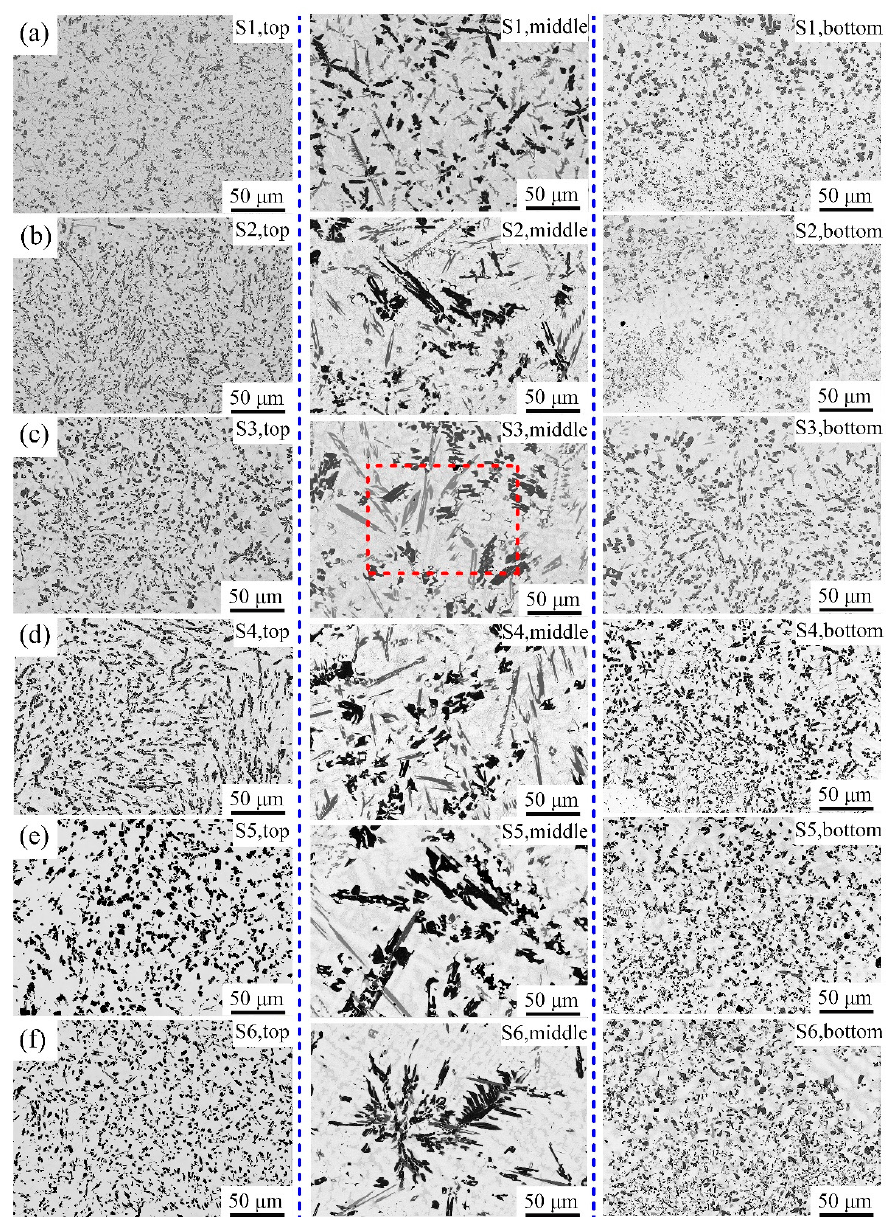
Figure 5. SEM images of the microstructure of the coatings from S1 to S6: ( a ) S1, ( b ) S2, ( c ) S3, ( d ) S4, ( e ) S5, and ( f ) S6. The magnified SEM micrograph corresponding to the area marked by a small rectangle in Figure 5c is shown in Figure 6a. It can be found that the microstructure mainly includes four phases: black blocky phases (indicated by Spot 1), dark gray strip-shaped phases (indicated by Spot 2), light gray dendritic phases (indicated by Spot 3) and a light gray matrix (indicated by Spot 4). The EDS analysis results of these points are shown in Figure 6b–e, and the atomic percentage of each marked point is listed in Table 3.